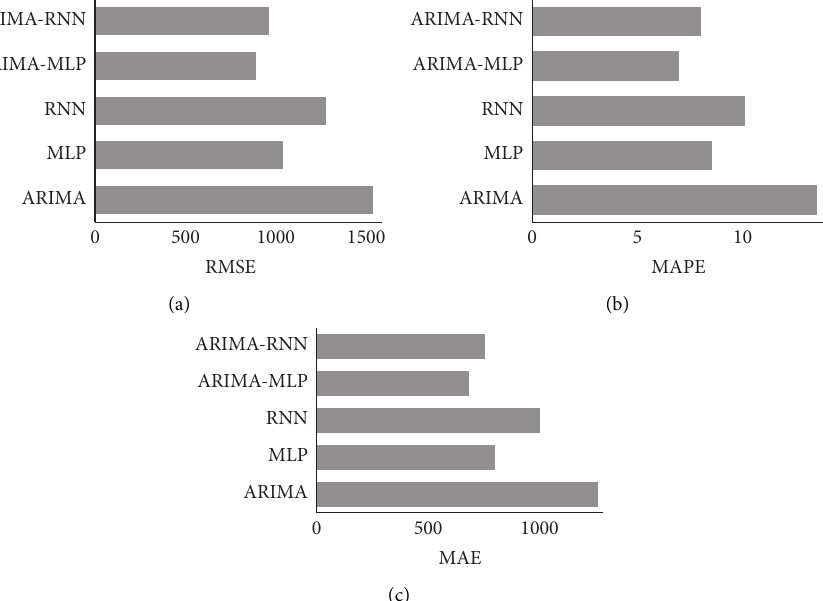
Figure 5: Forecast comparison across different models for India.